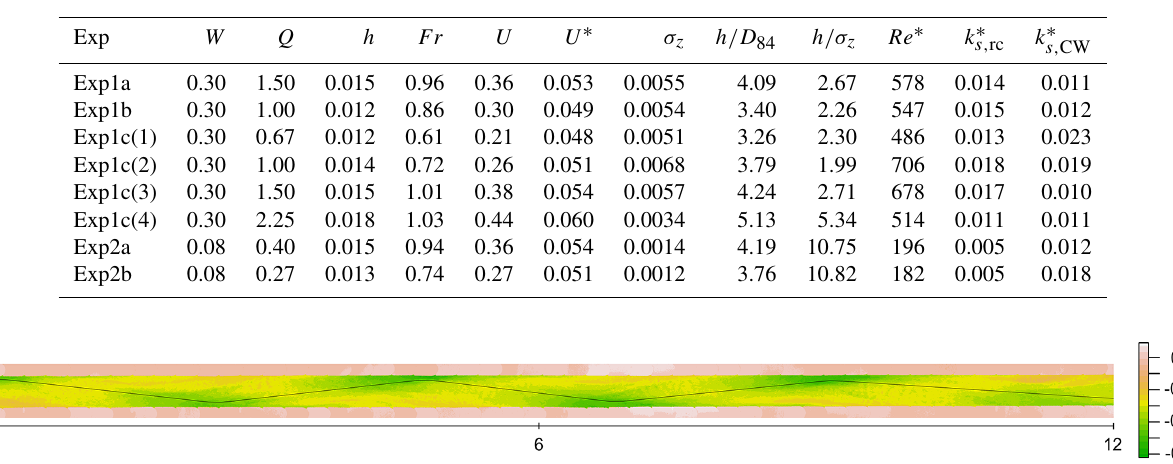
Table 2. Summary of A-BES experimental data collected during the final portion of each experimental phase. Values represent the mean of the last five measurements. The reported σ z values were calculated following the detrending process detailed in Sect. 3.2, and Re ∗ was calculated with k = D 84 . The roughness length k ∗ s, rc is defined in Sect. 3.2. Units: W [m], Q [L/s], h [m], U [m/s], U ∗ [m/s], σ z [m], k ∗ s [m].